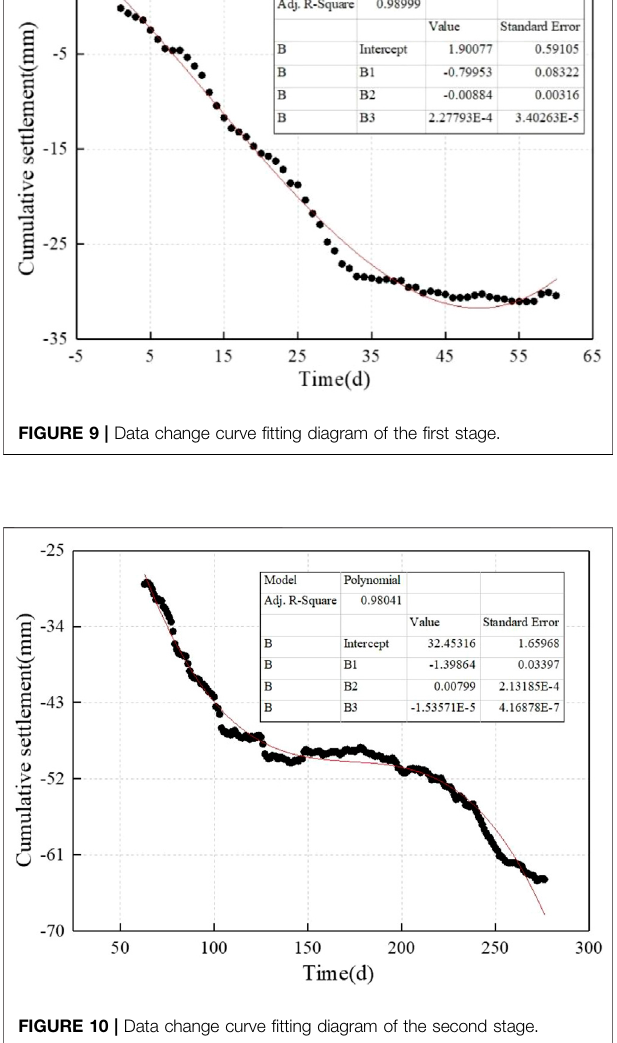
FIGURE 10 | Data change curve fi tting diagram of the second stage.